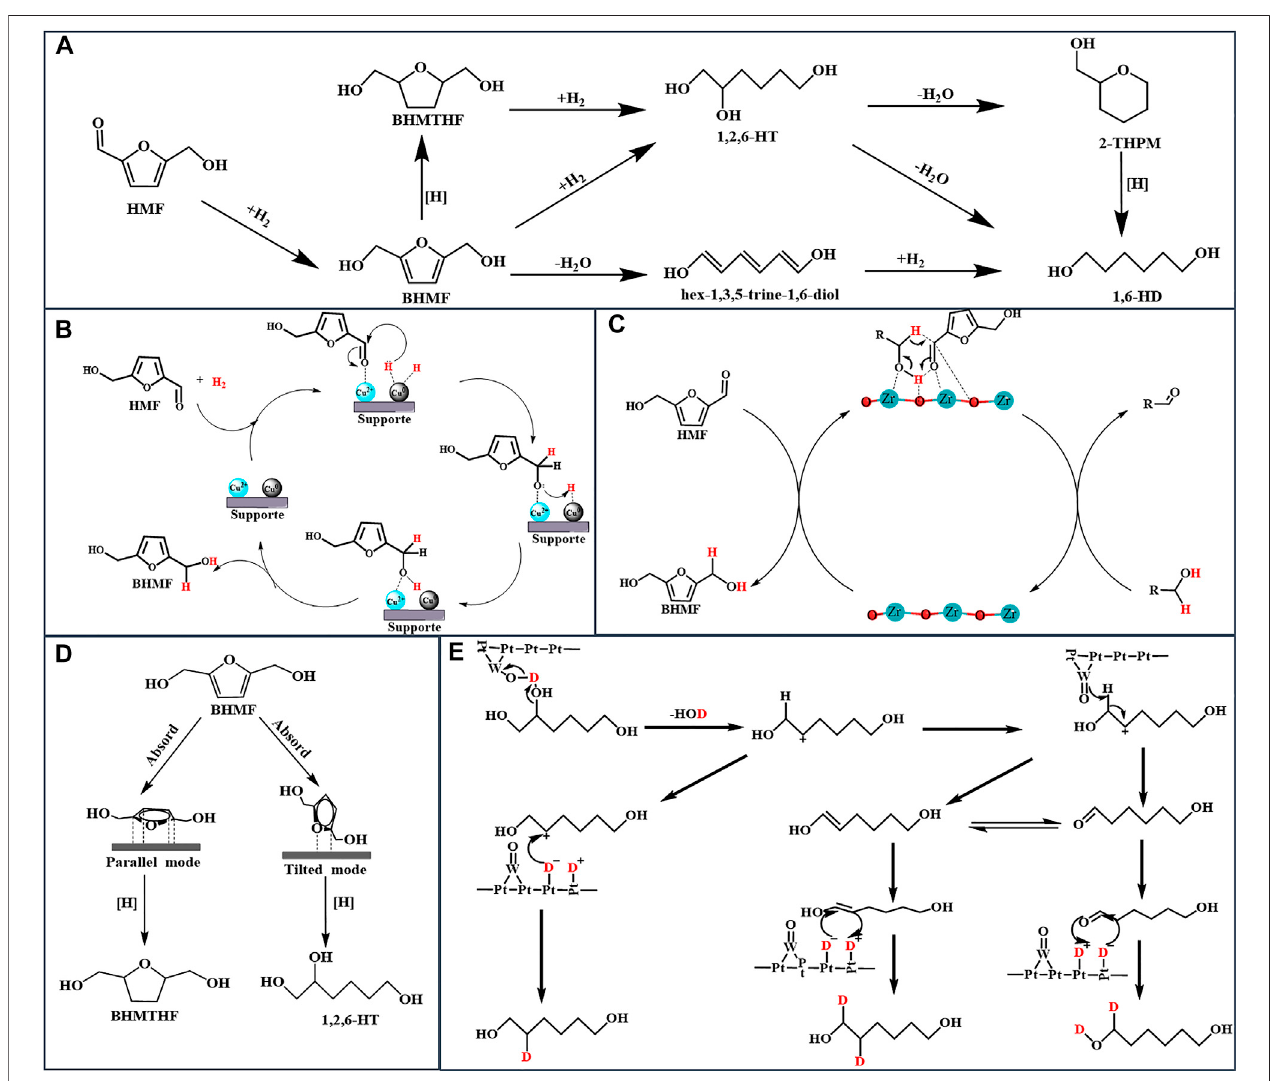
FIGURE 1 | (A) : The route of formation of 1,6-HT from HMF; (B) : Mechanism for the selective conversion of HMF to BHMF over the Cu/Al 2 O 3 catalyst (C) : MechanismfortheCTHofHMFtoBHMFovertheZr-basedcatalyst (D) :Adsorptioncon fi gurationsofBHMF (E) :MechanismfortheselectivecleavageofC-OHoverthe Pt-WO x /TiO 2